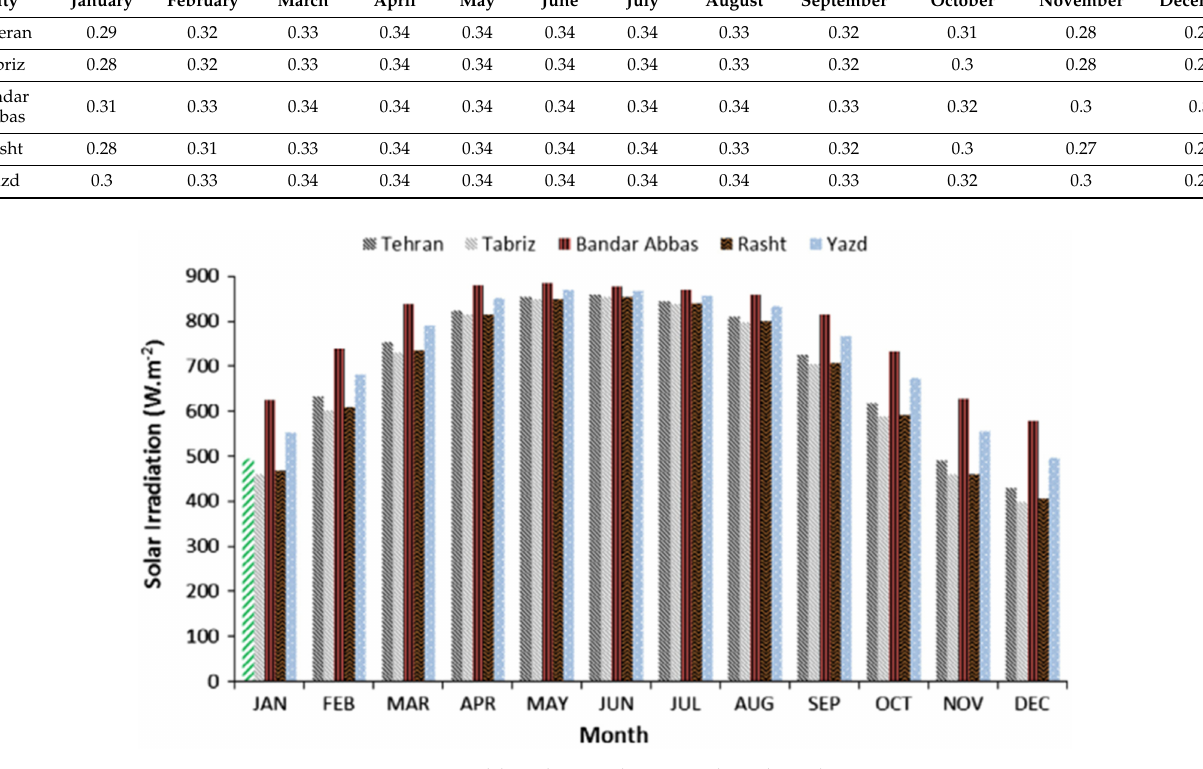
Figure 13. Monthly solar irradiance in the selected